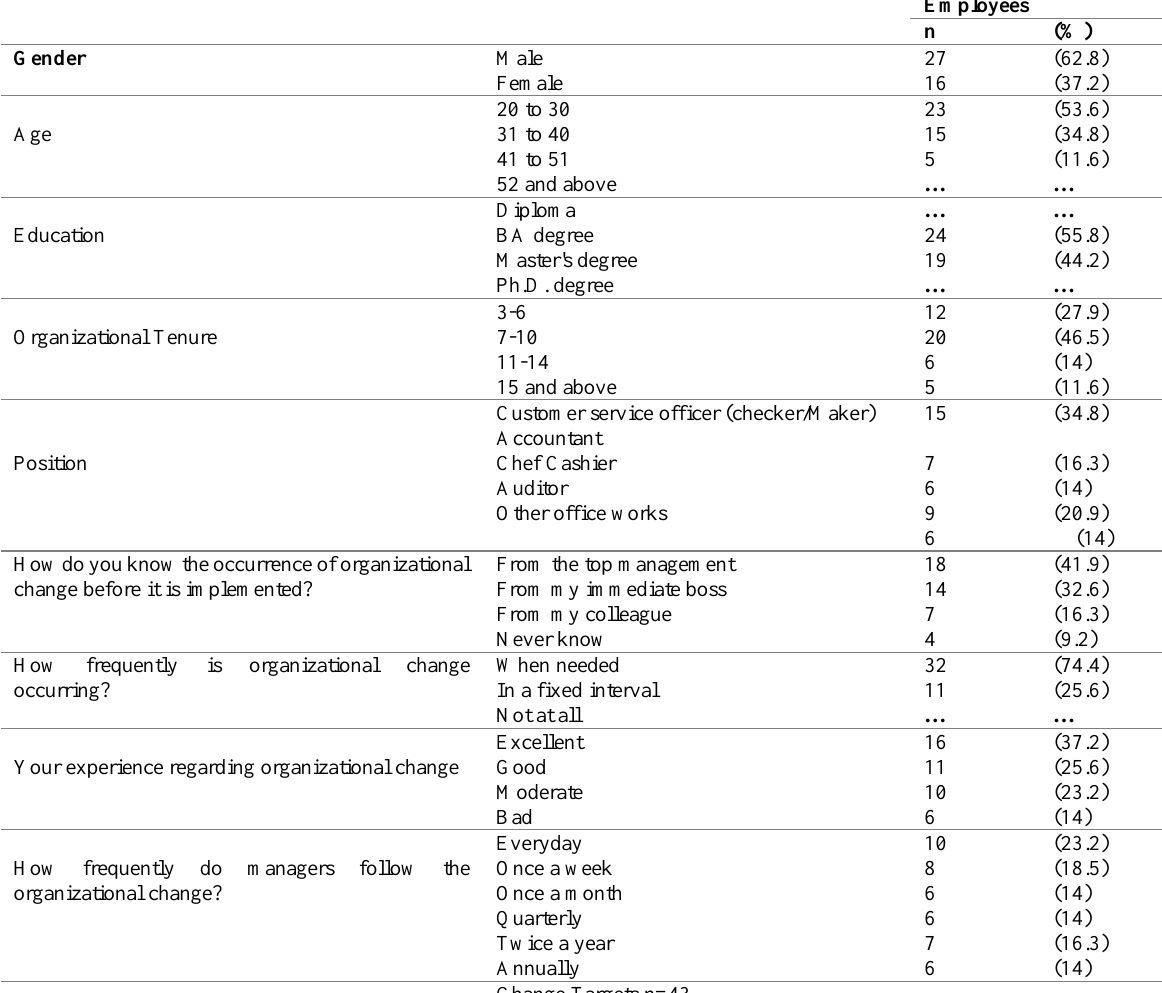
Table 1: Demographic Characteristics of